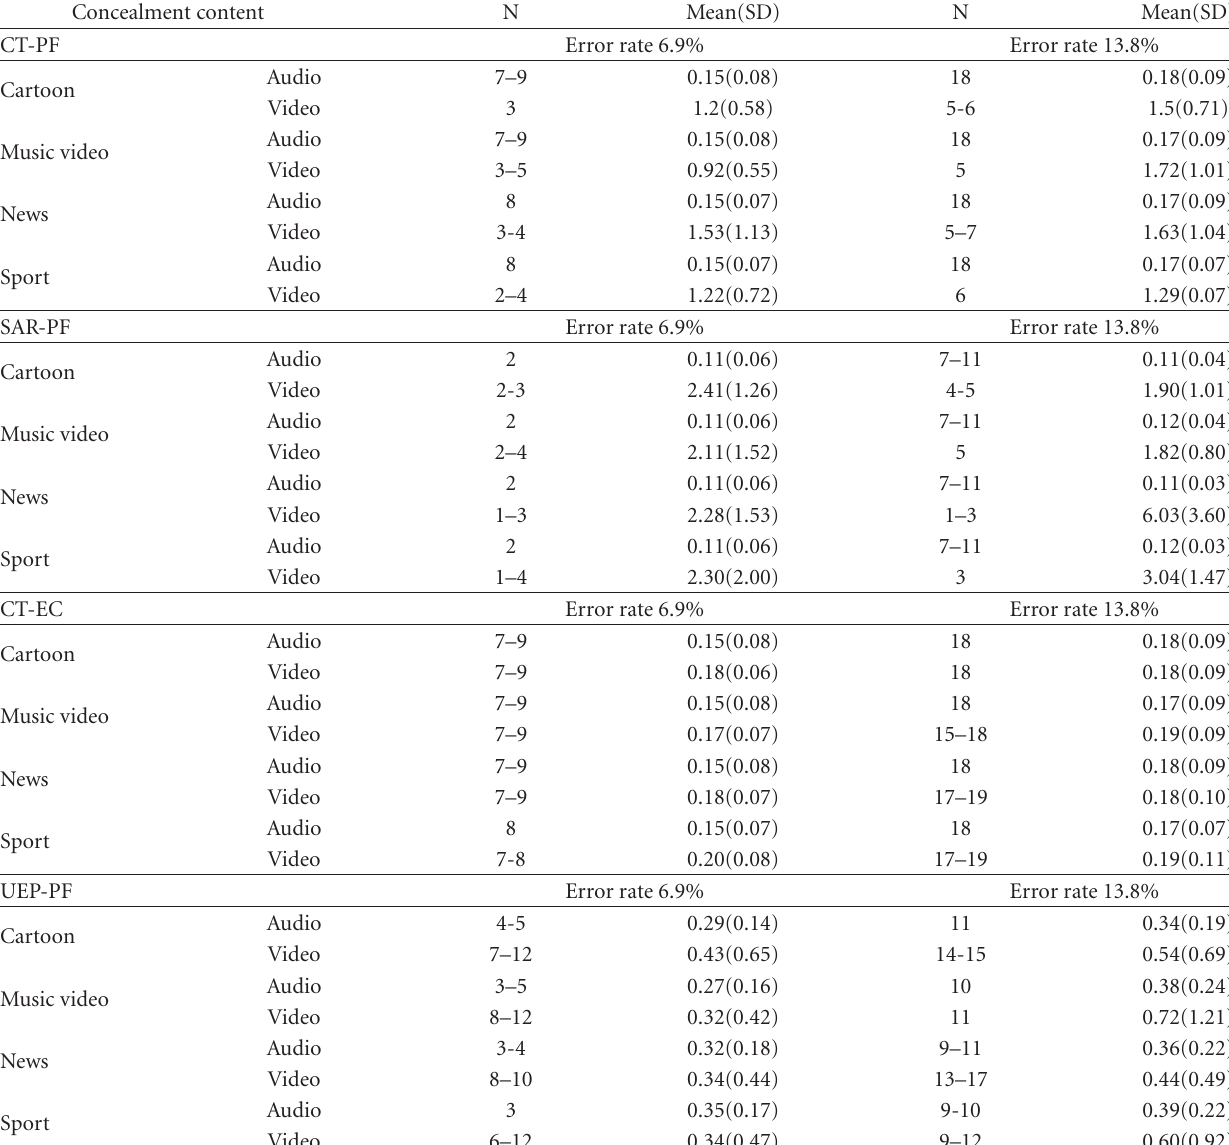
Table 3: Number of errors, mean durations and standard deviation (in seconds) of burst errors for error patterns in di ff erent error rates and error control